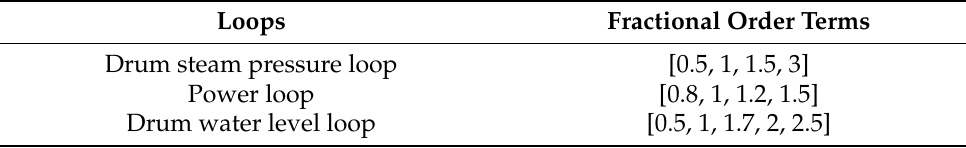
Table 3. Fractional order terms for each